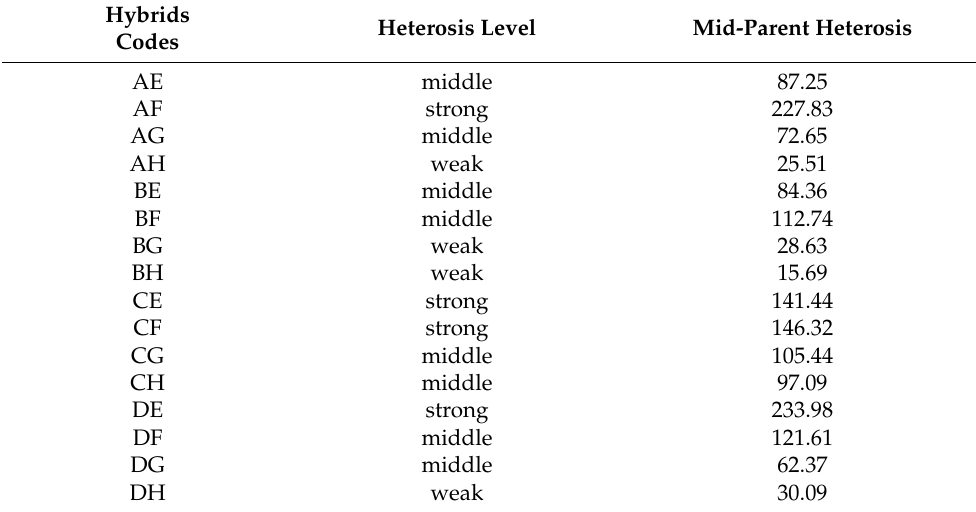
Table 2. Mid-parent heterosis value analysis of plant gross weight in